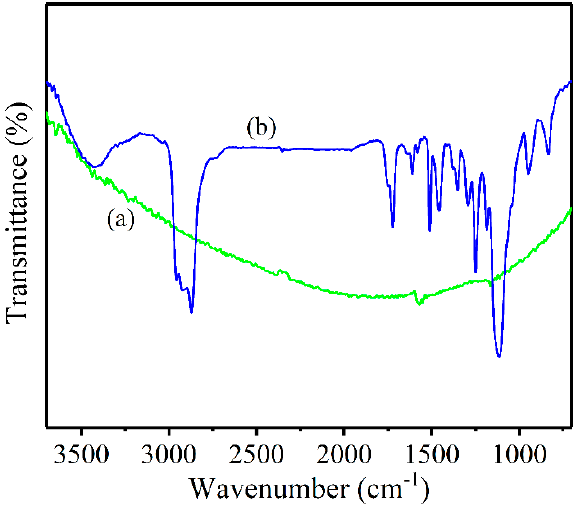
Figure 5. FT-IR spectra of ( a ) GNPs and ( b ) CNT@X+GNPs particles.